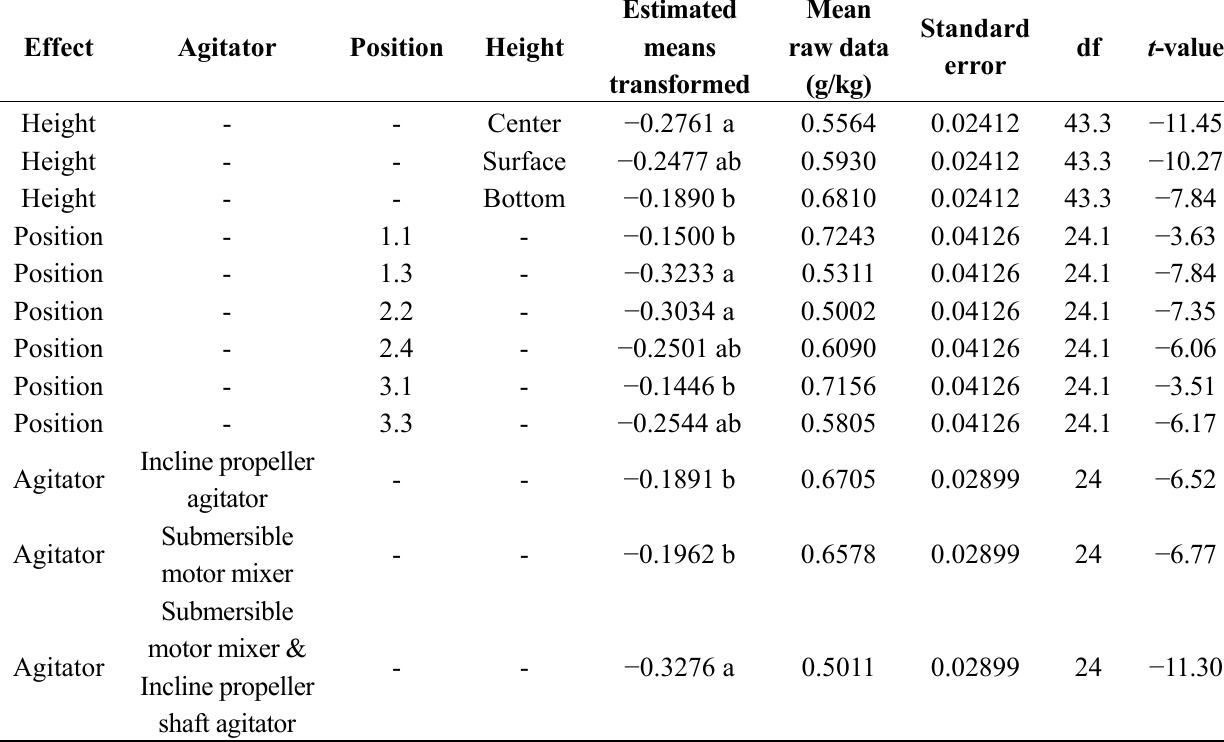
Table 5. Comparison of means of acetic acid with different letters showing the significant difference between the means of estimated values.